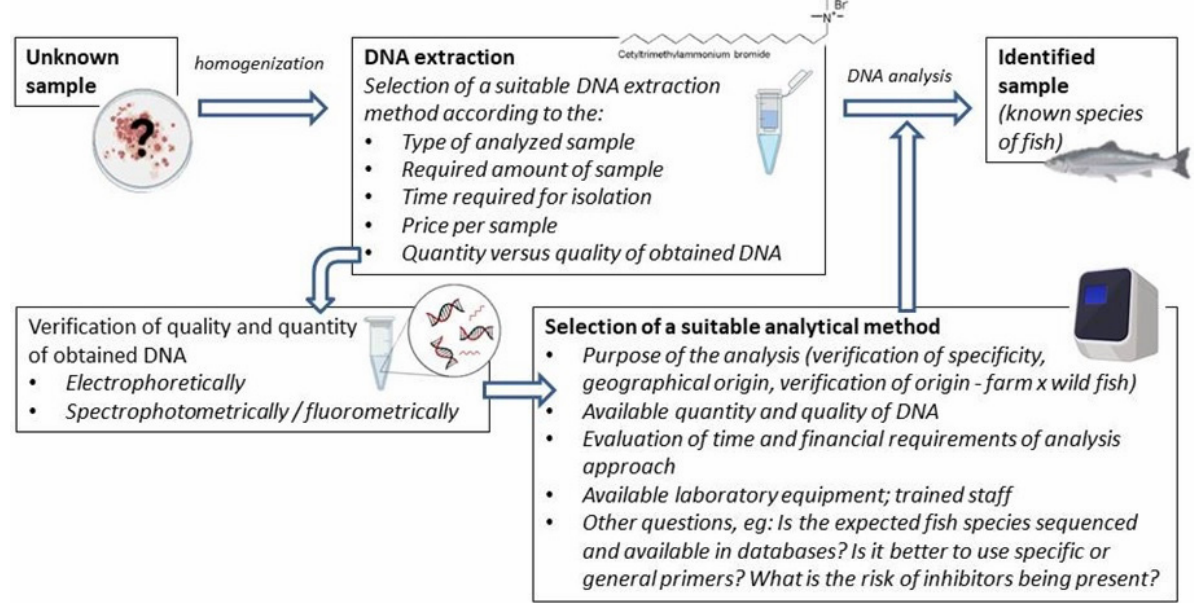
Figure 1. Scheme of the general procedure using DNA-based methods.